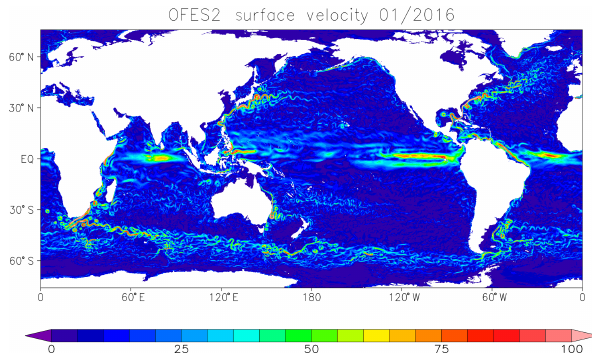
Figure 1. An example of monthly averaged surface current speeds (cms − 1 ) in